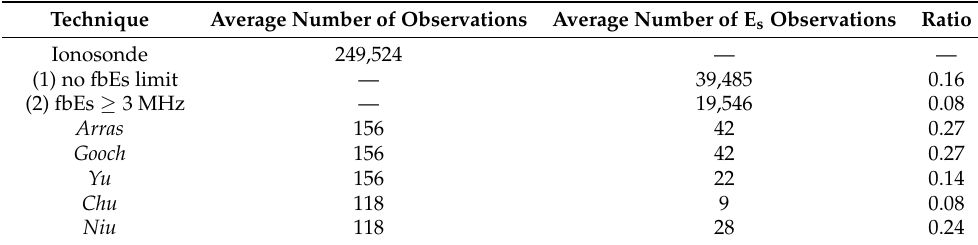
Table 2. Average number of ionosonde and GPS-RO observations over each site for all seasons and years.